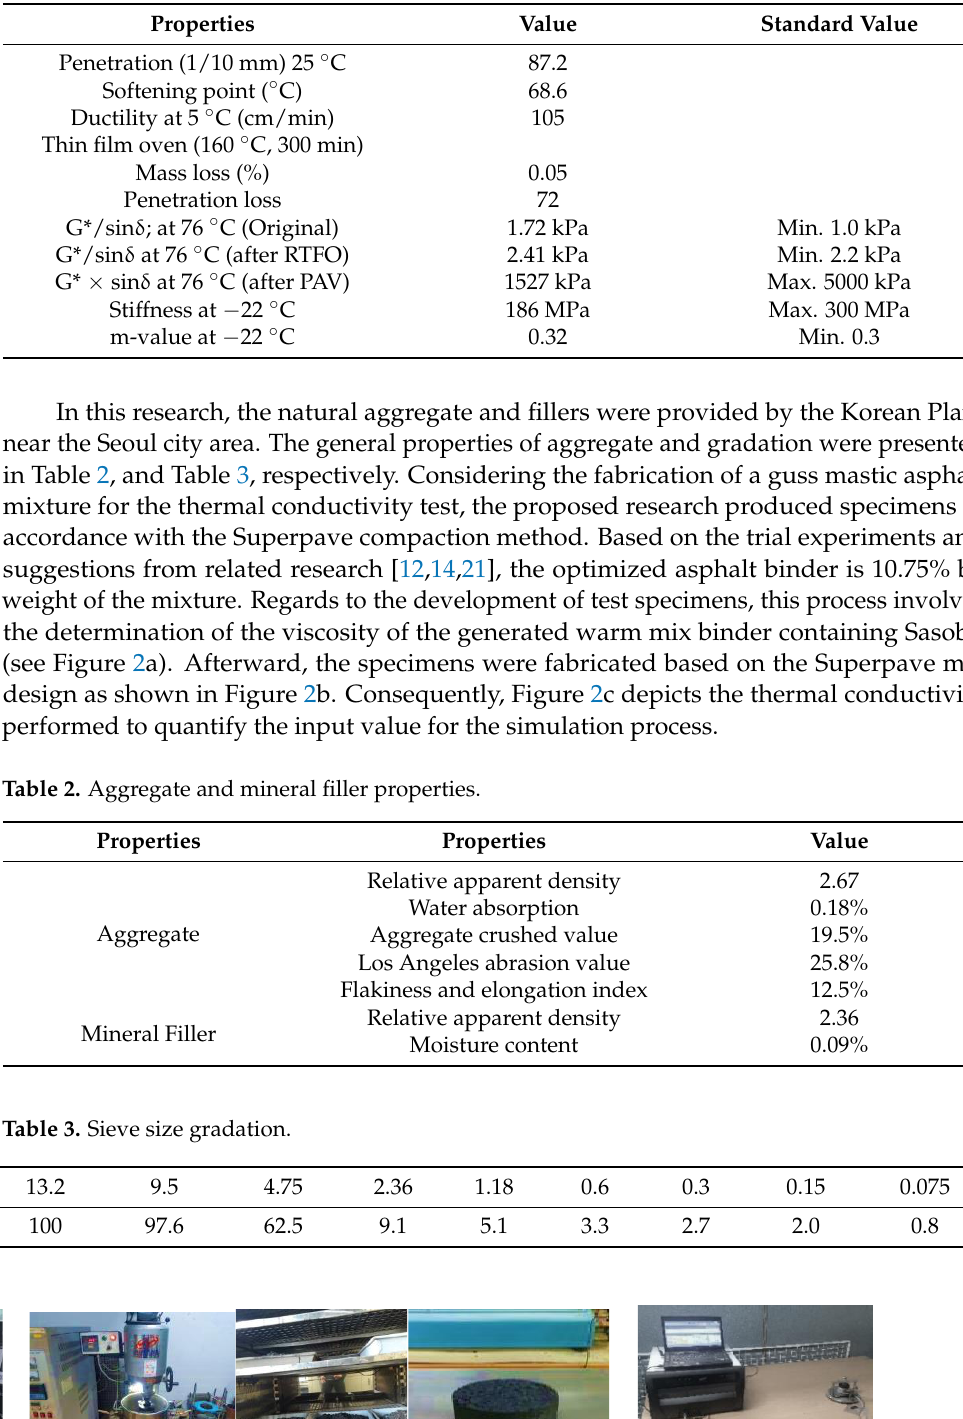
Table 1. Properties of guss mastic asphalt binder.